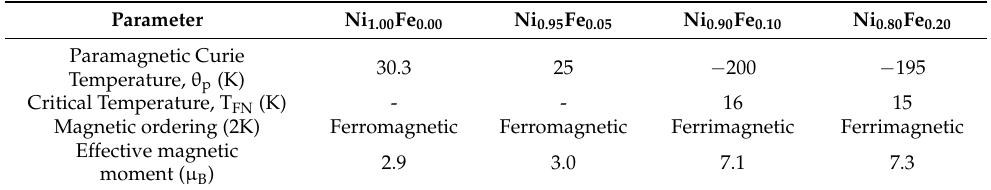
Table 2. Magnetic characteristics of α -Ni(OH) 2 and iron-substituted α -Ni(OH) 2 nanosheets.